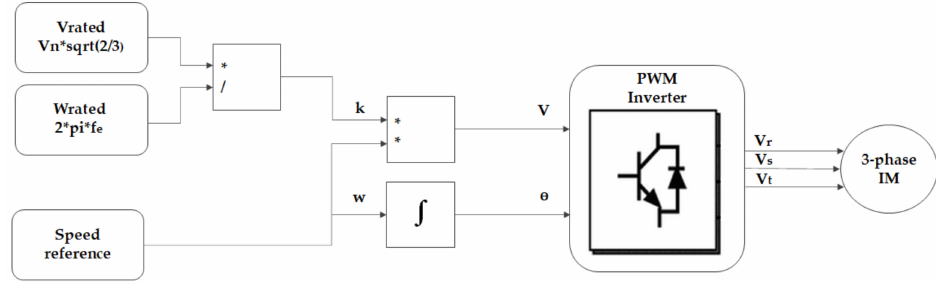
Figure 2. Conventional V/Hz control strategy block